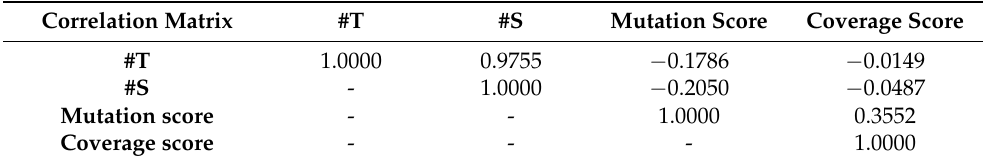
Table 3. Correlation coefficient matrix for output